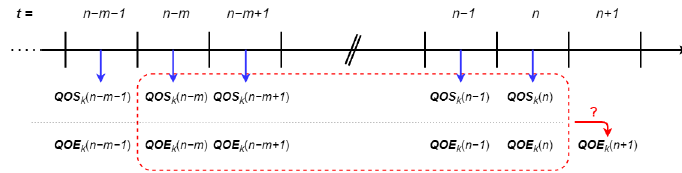
Figure 3. QoE prediction based on previous QoS/QoE